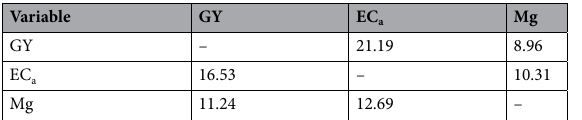
Table 3. Similarities between maps by relative deviation coefficient (RDC) in relation to grain yield (GY), soil apparent electrical-conductivity